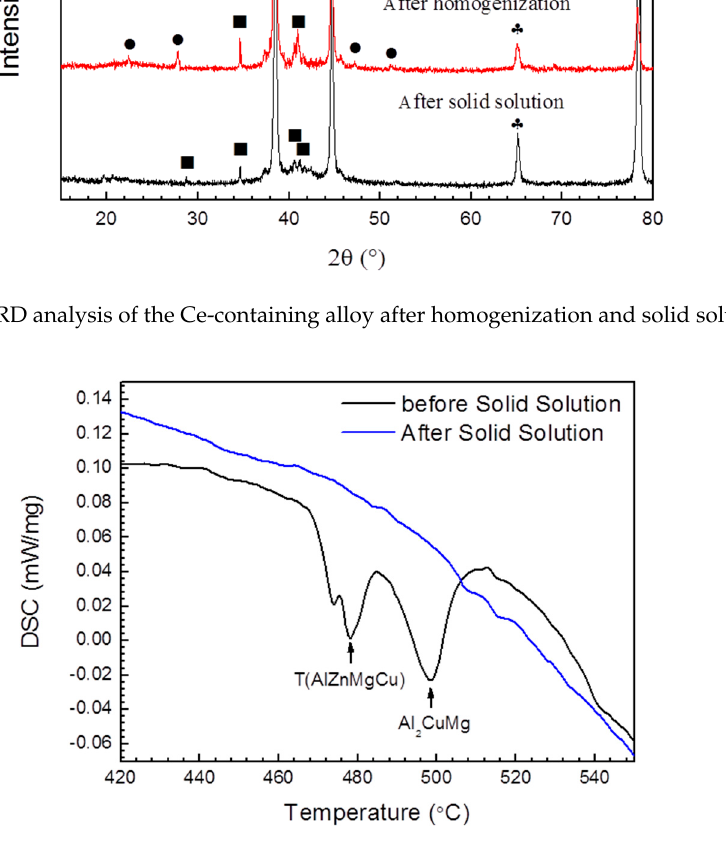
Figure 3. DSC curves of the Ce-containing alloy before and after solid solution treatment.